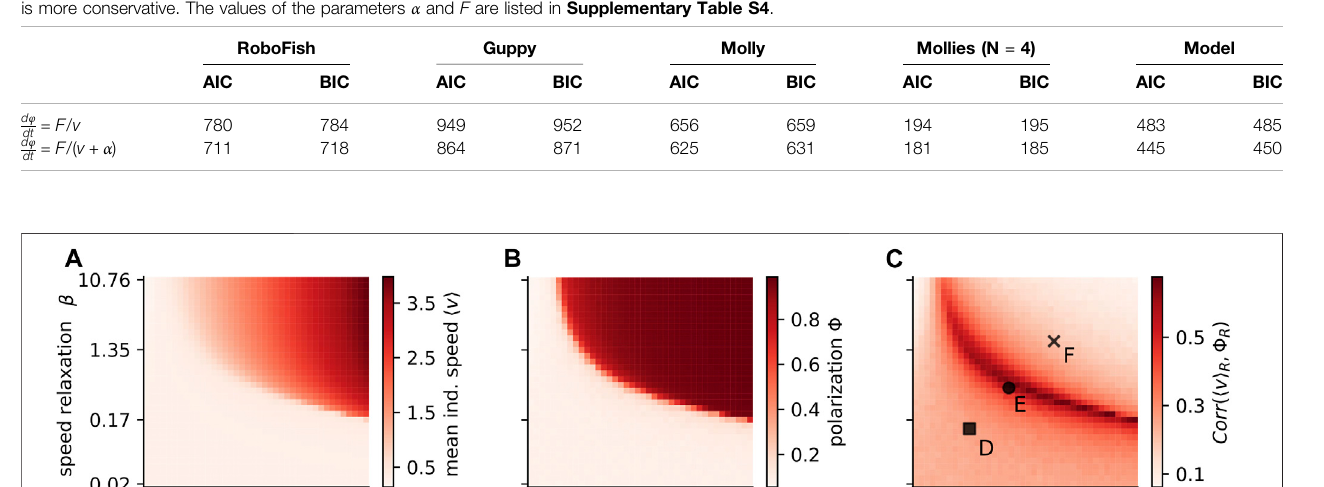
(cid:1) F / v ) and with( d φ (cid:1) F /( v + α )) turning-friction α for each dt dt